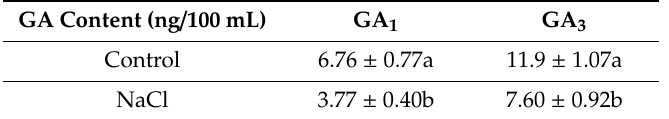
Table 3. Gibberellins acid content of P. koreensis MU2 pure culture under normal and salt-stressed